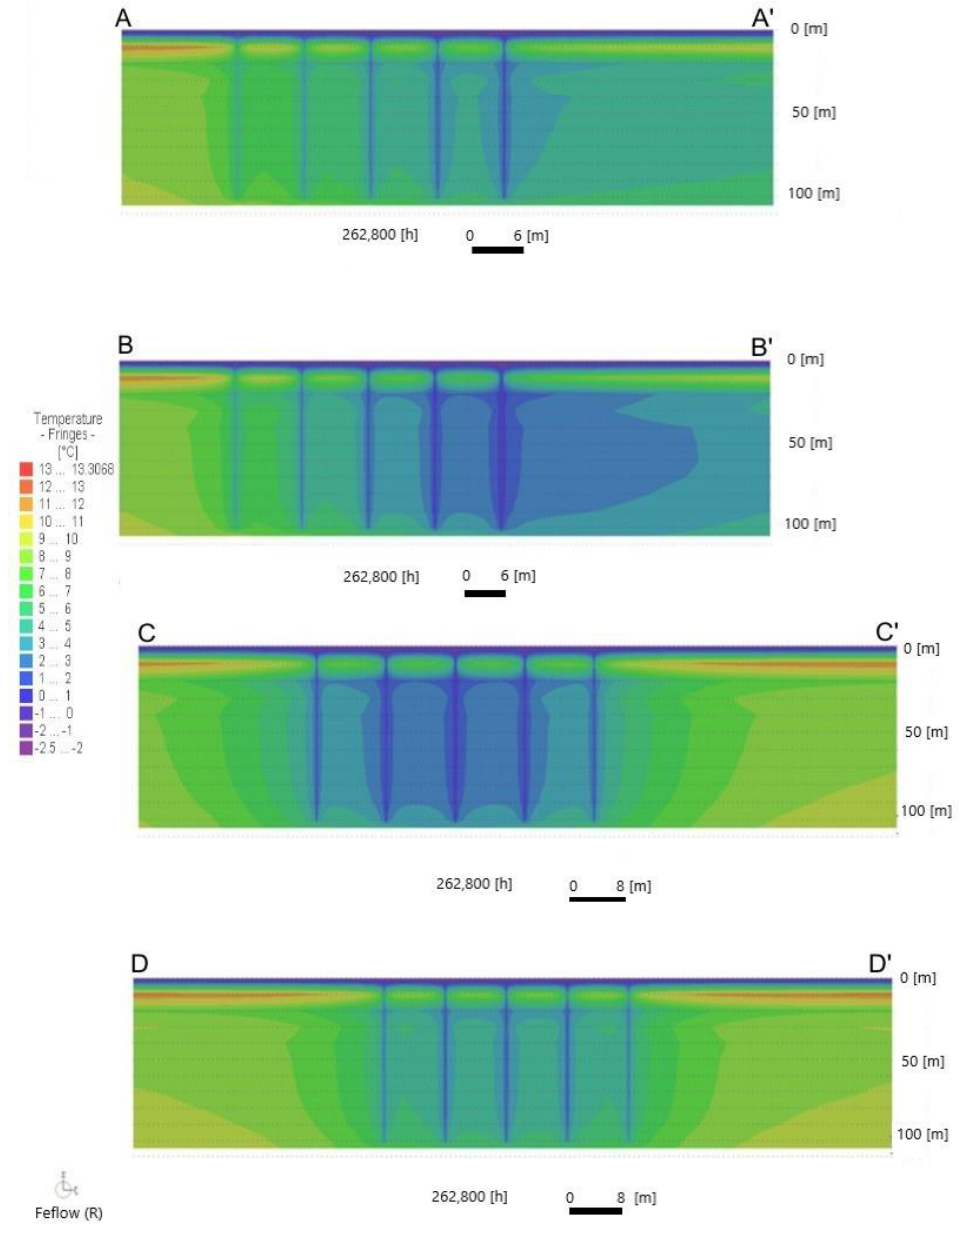
Figure 8. The temperature distribution as cross-section views for the 1st scenario. The cross-section lines are the same as those in Figure 1.